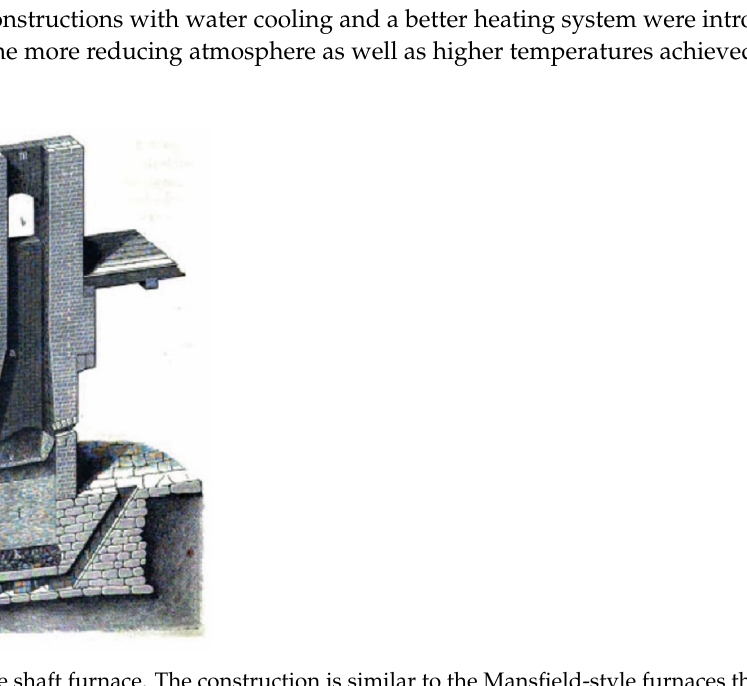
Figure 7. Simple shaft furnace. The construction is similar to the Mansfield-style furnaces that were used in Leszczyna. Drawing after Stolarczyk et al.